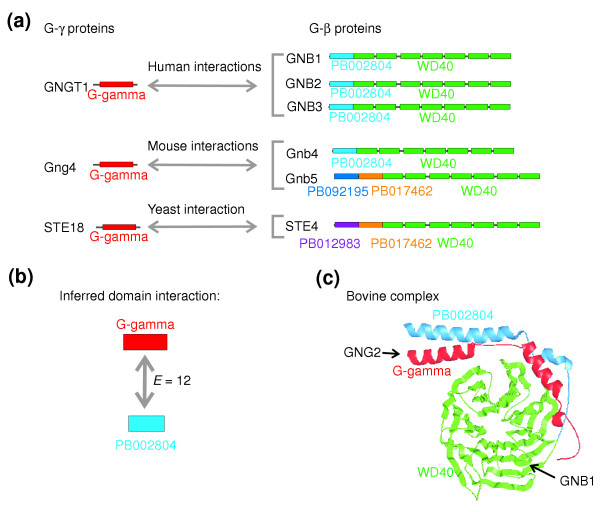
Inferred domain interactions of G-protein subunits. (a) Domain structures of interacting G-γ and G-β proteins in human, mouse and yeast. Protein names are in black to the left of each protein's domain structure schematic. Domains of proteins are colored boxes connected by a gray line. Pfam-A domain names and Pfam-B accession numbers are the same color as the domains they label. Domain structures are schematic and are not to scale. (b) Of the possible domain interactions, only that of G-gamma [Pfam:PF00631] and a Pfam-B domain [Pfam:PB002804] is inferred with high confidence (E = 12). (c) A published structure of complexed G-protein γ and β subunits [PDB:1GP2] [37] confirms our prediction that the G-gamma and PB002804 domains can interact.